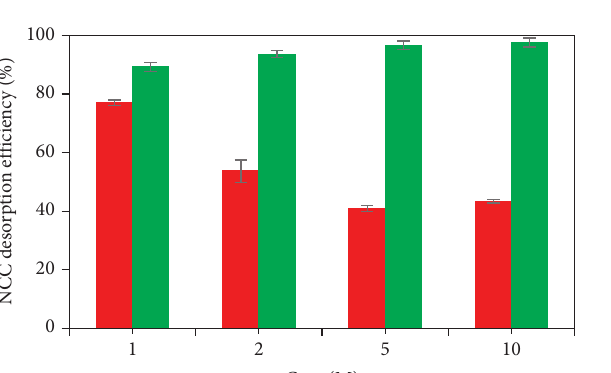
Figure 12: Effect of the HCl concentration to regenerate α -Al